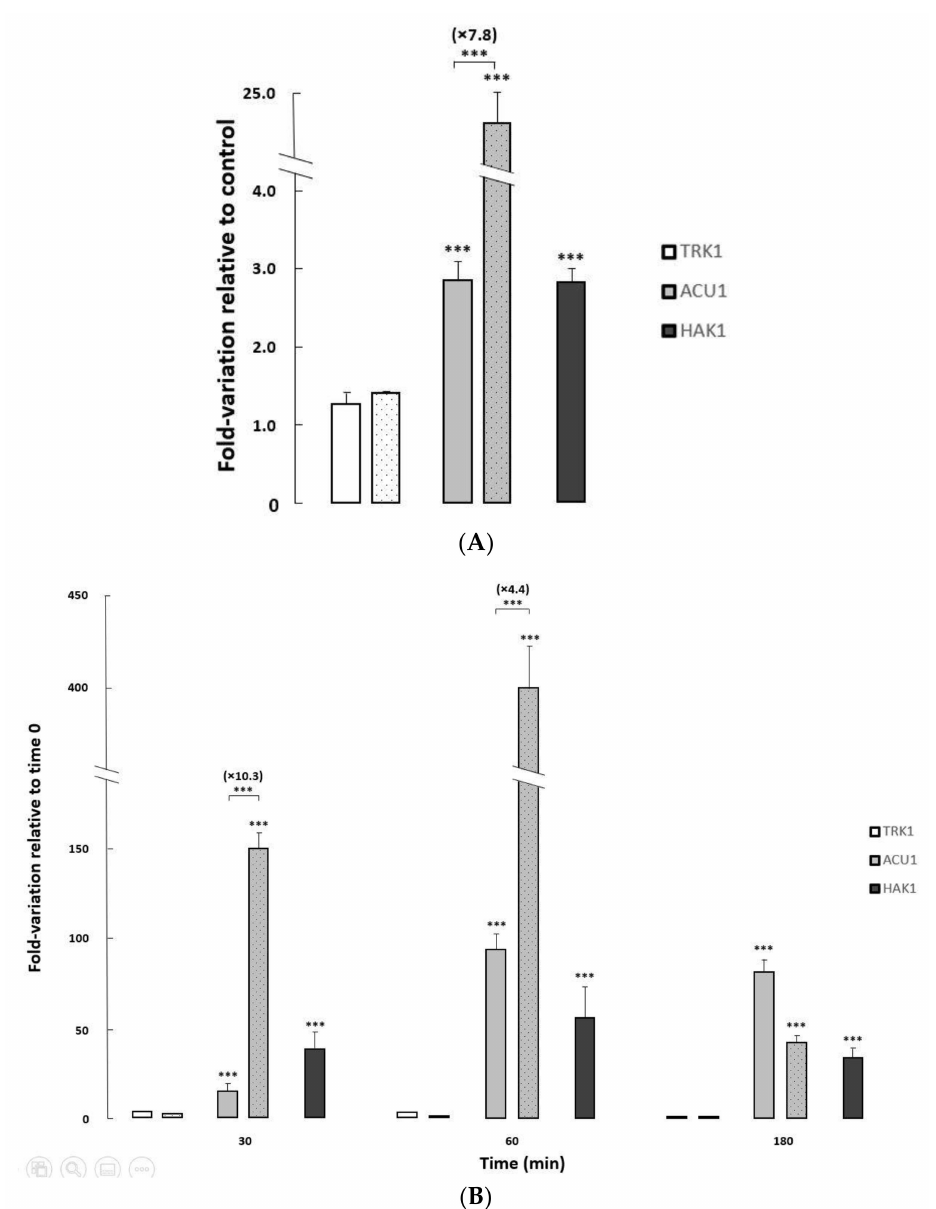
Figure 4. Changes in expression levels of potassium transporter genes in C . albicans HAK1+ and hak1 − strains. ( A ) The cells were grown overnight in YNB liquid medium (Control) and in YNB medium supplemented with 1 M NaCl to an A 600 of 0.6–0.7. ( B ) Normal-K + cells were grown to exponential phase, washed and resuspended in YNB-F without KCl, and further incubated. Samples were taken at different times during potassium starvation (0, 30, 60 and 180 min). All transcript levels are referred to those for the controls ( A ) or time 0 ( B ). The HAK1+ strain was represented by filled bars while the mutant strain was represented by dotted bars. Mean values ± standard deviations were obtained from at least three independent experiments. Statistically significant compared to the controls/time 0 and comparing the strains (square brackets) expressed as: *** p <